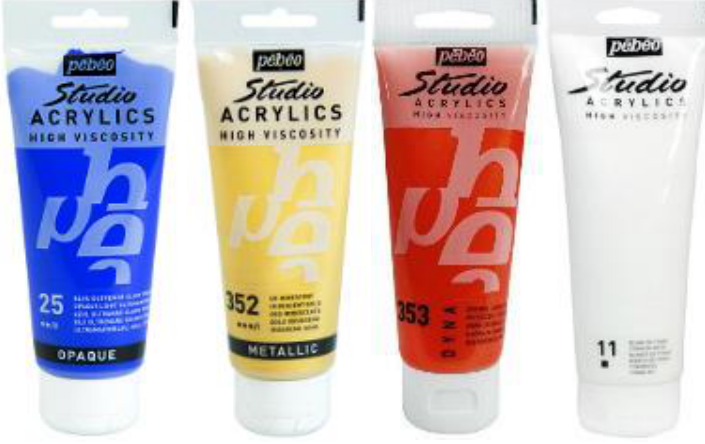
Figure 1. Acrylic paints used in the experiment (brand: Pebeo, Gémenos, France).